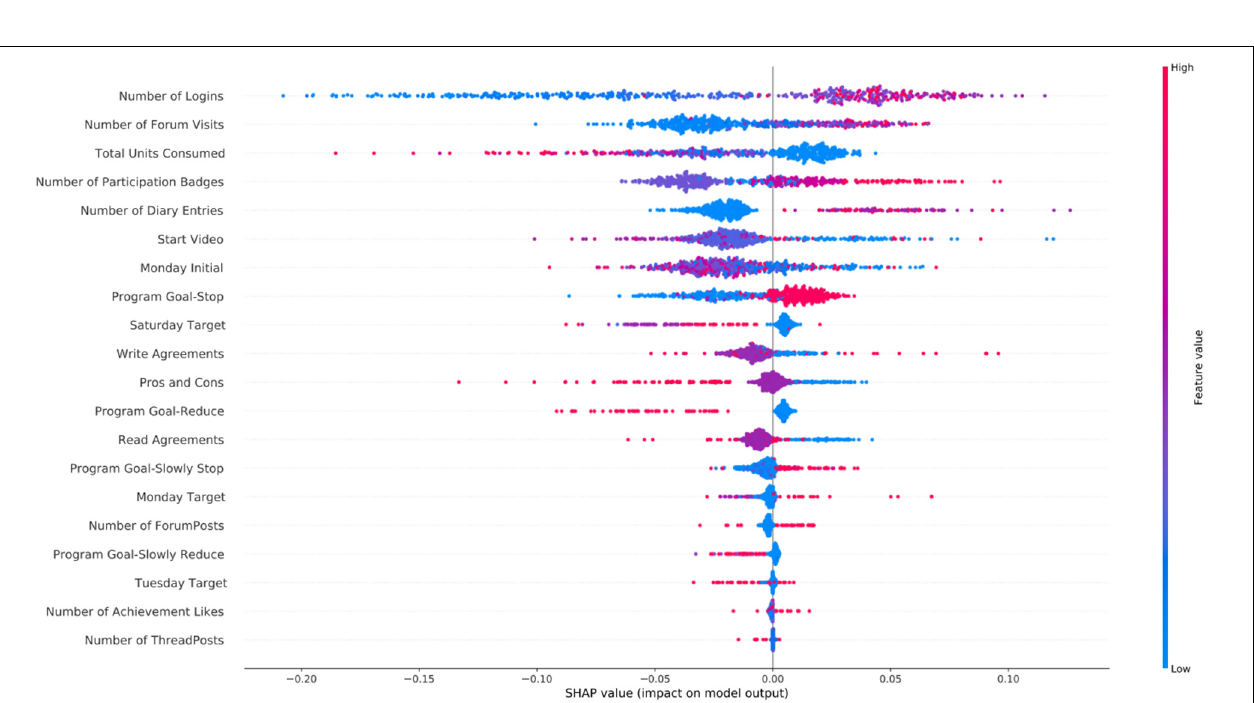
FIGURE 4 | SHAP feature importance for the cannabis intervention using the RFC model. For visualization purposes we included only the top 20 features. In the y -axis, we have the features based on the first 72 h of participation in order of importance from top (most important) to bottom (less important) and in the x -axis their respective SHAP value which indicates their association with success (SHAP values are above zero) or early dropout (SHAP values below zero) participant outcomes.